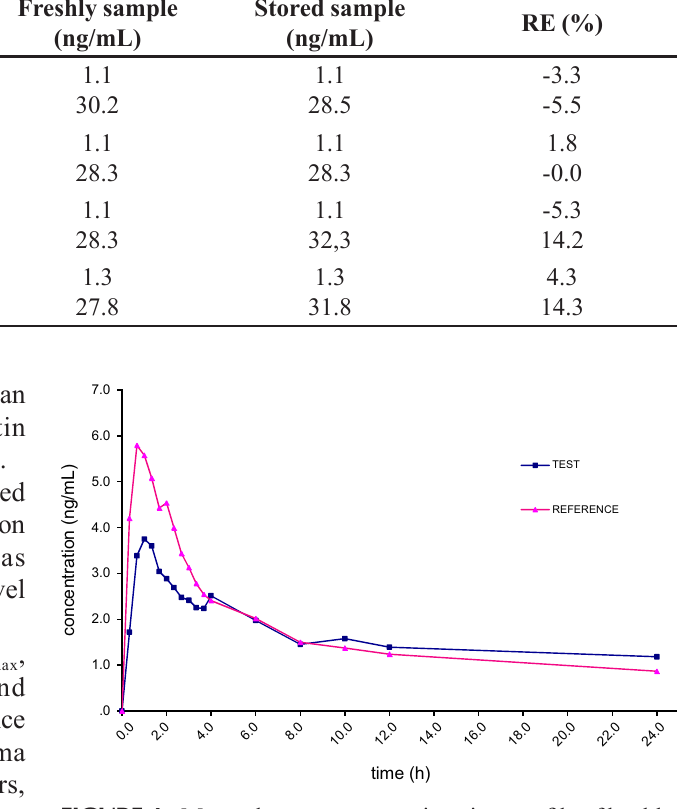
TABLE IV - Pharmacokinetic parameters for test and reference drugs in healthy subjects in bioequivalence study Parameters